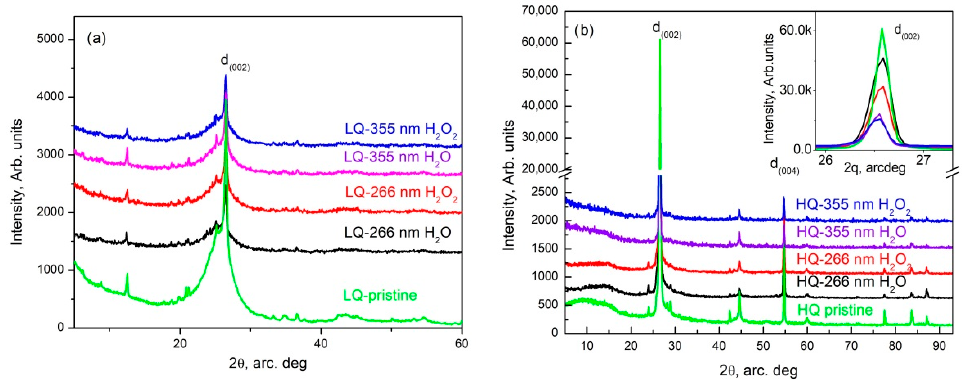
Figure 8. XRD pattern of LQ ( a ) and HQ ( b ) specimens.